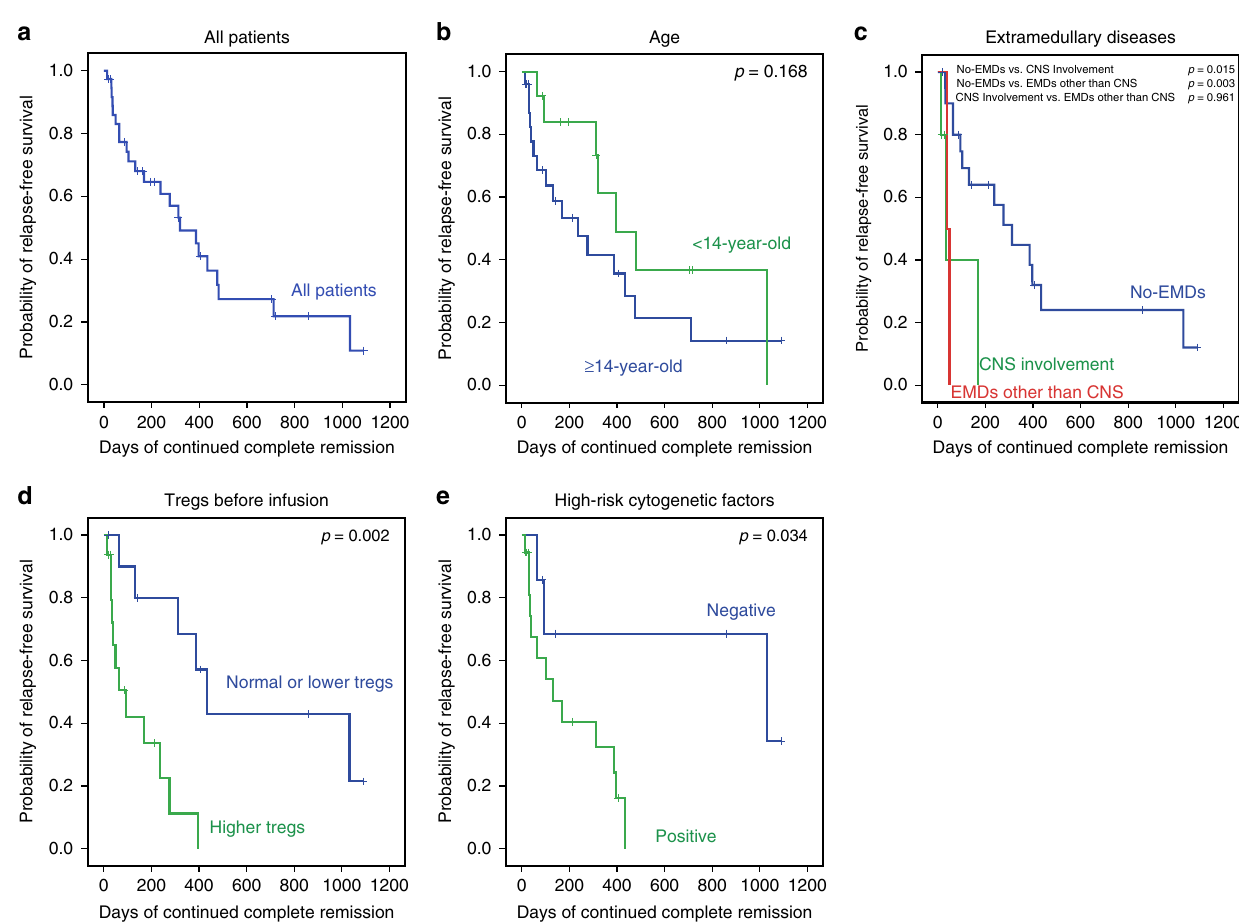
Fig. 3 Relapse-free survival (RFS) and subgroup analysis. a The RFS in all patients who received infusion, the median RFS was 319.0 days (95% CI: 182.6 – 455.4). The rate of RFS at 1 year was 45.0% (95% CI: 26.8 – 63.2). b The RFS between pediatric and adult cohort, no signi fi cant difference observed ( p = 0.168). c The RFS in patients with the 2 subtypes of EMDs (CNS involvement only or EMDs other than CNS) were lower than that in patients without EMDs ( p = 0.015 and 0.003), respectively, but no signi fi cant difference existed between the subtypes ( p = 0.961). d The RFS in patients with or without higher Tregs before infusion, 1-year RFS rate was 11.9% vs. 56.7% ( p = 0.002). e The RFS in patients with or without high-risk cytogenetic factors, 1-year RFS rate was 24.2% vs. 67.7% ( p = 0.034). Patients who were bridged to allo-HSCT were excluded when we analyzed the in fl uence of patient characteristics on RFS ( c – e ). b – e were performed by the Kaplan-Meier approach and used a two-sided log-rank test. Source data is provided as a Source Data fi le or available at https://doi.org/10.6084/m9. fi